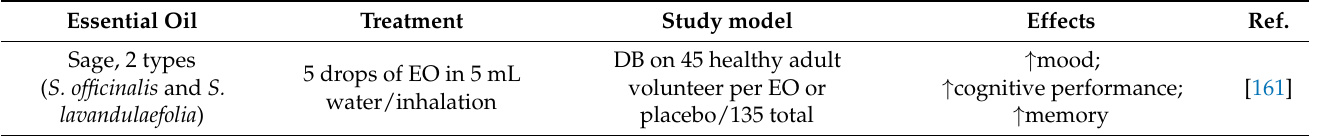
Table 3. Representative clinical trials of the impact of essential oils on mood and cognitive performance. Essential